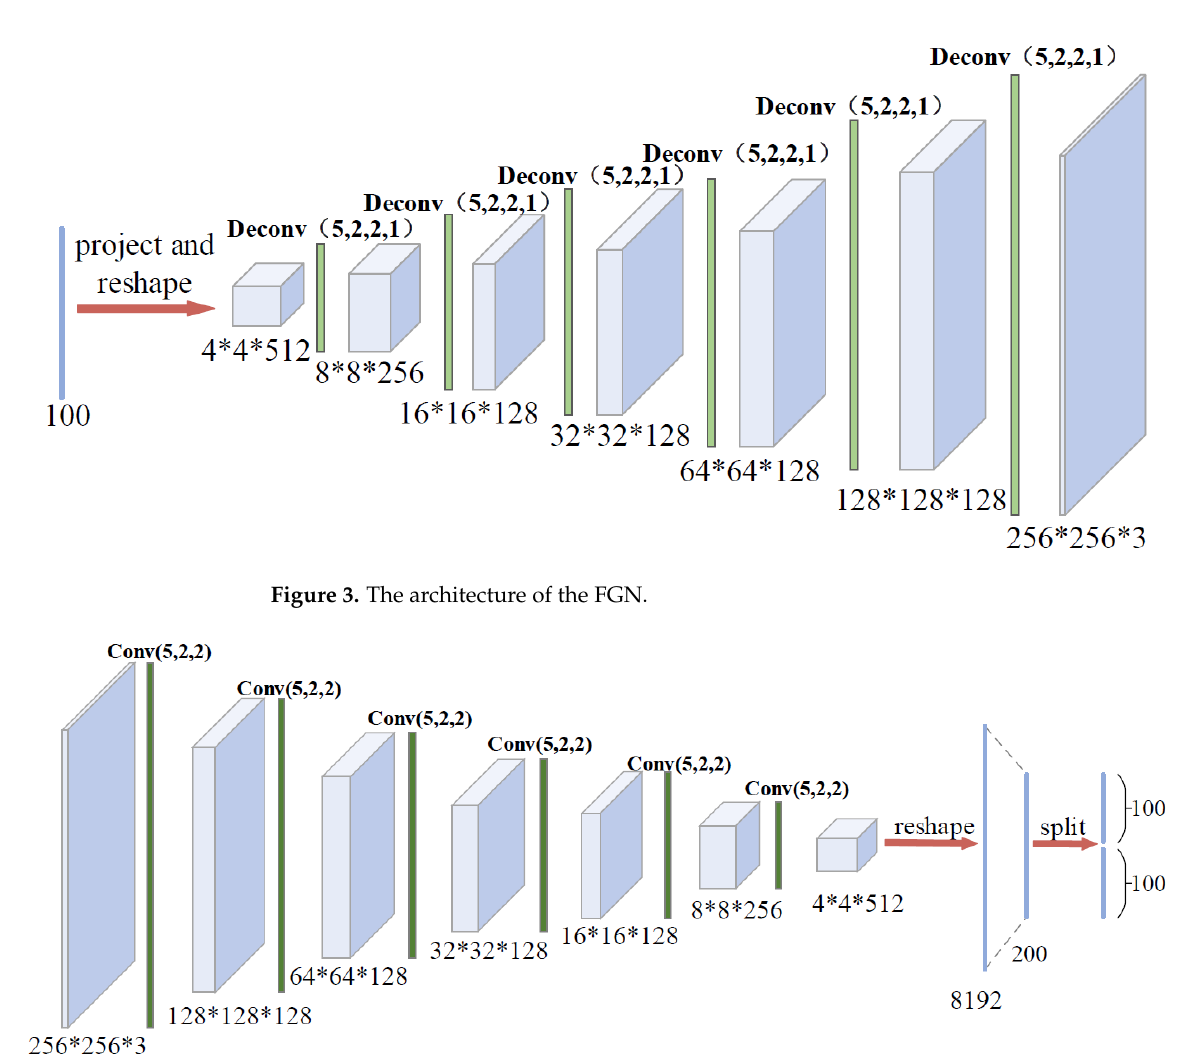
Figure 4. The architecture of the